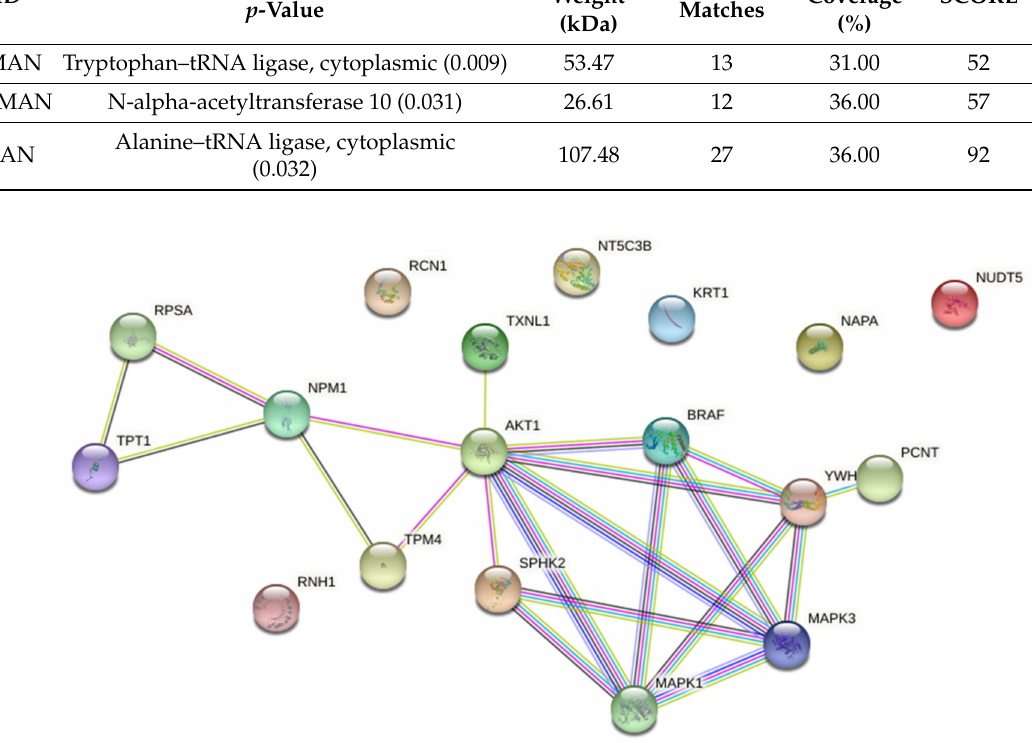
Figure 7. Protein-protein interaction (PPI) network of down-regulated proteins in resistant RKOr cells after combined treatment with ABC294640 and PLX4032 enriched with BRAF, SPHK2, ERK1/2 and AKT1. The PPI network was constructed using the STRING database of known and predicted protein-protein interactions with highest confidence of